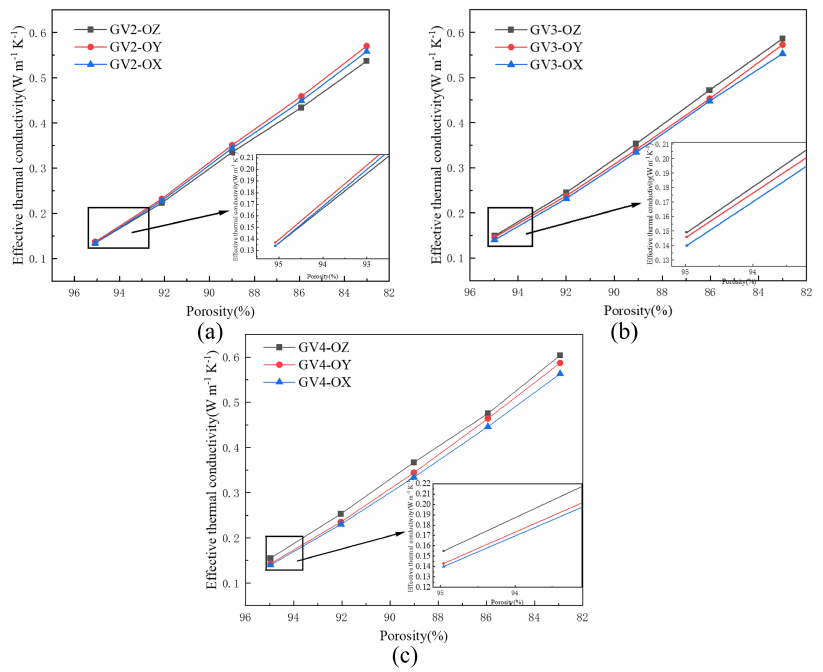
Figure 12. Effective thermal conductivity of various voronoi porous structures with different gradient orientations: ( a ) GV2; ( b ) GV3; ( c ) GV4